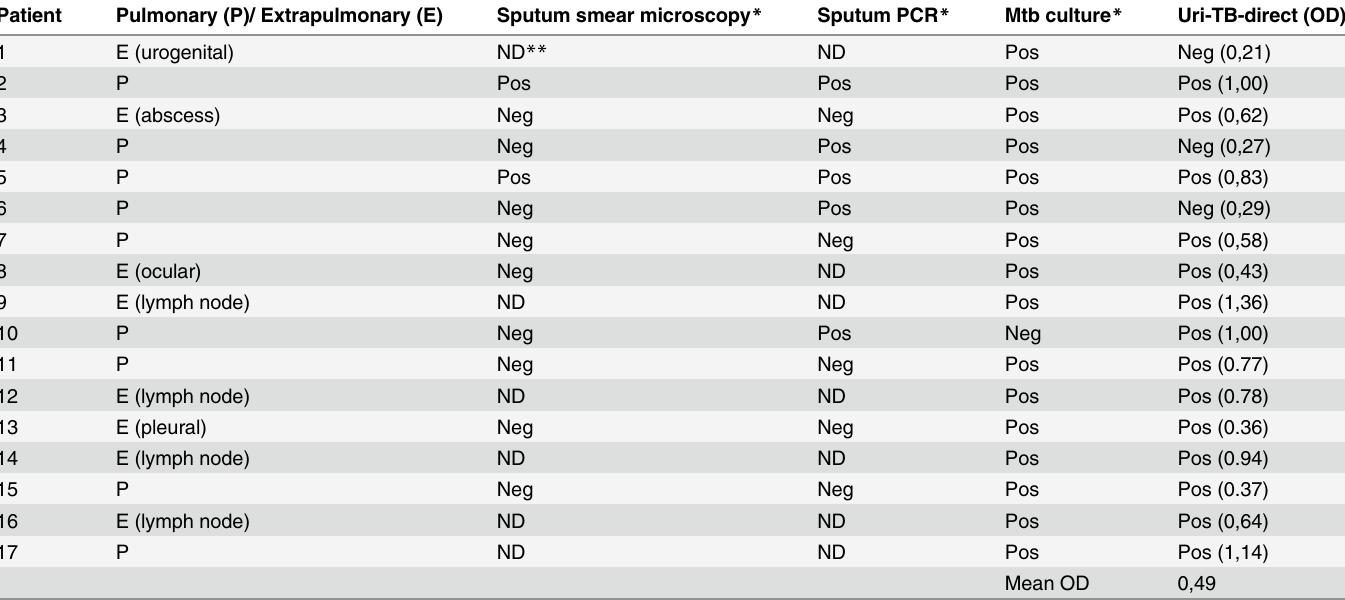
Results in optical density (OD) at absorbance 450